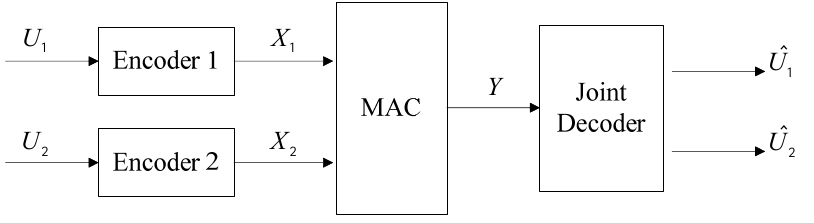
Figure 4. The system model of DJSCC for the MAC